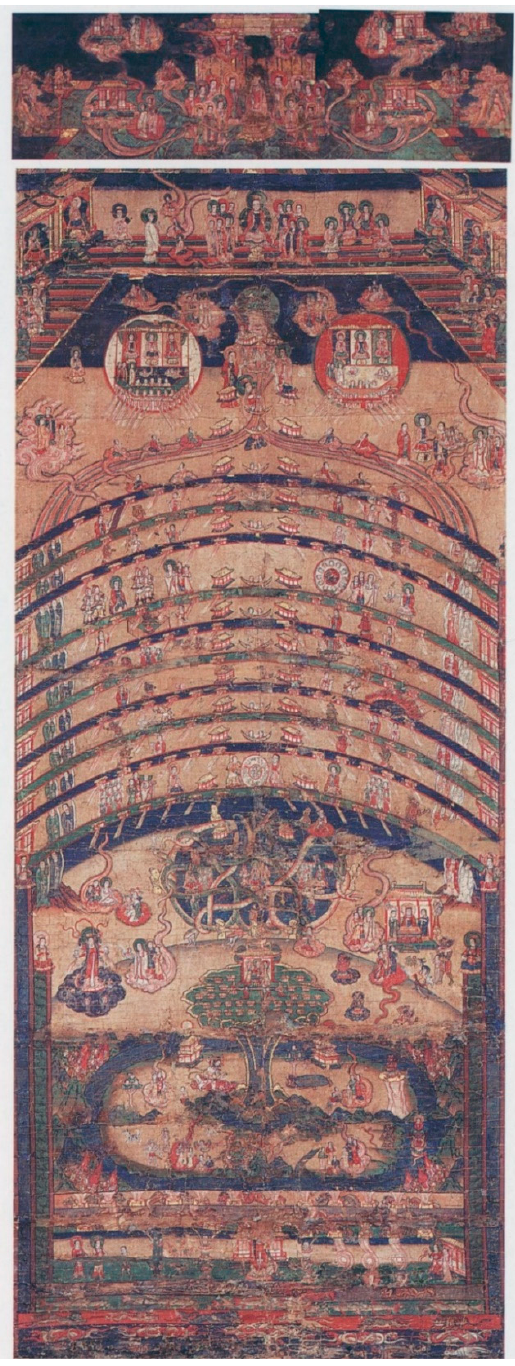
Figure 2. The Diagram of Universe . (Gulácsi 2016, Figure 5/14 [p. 248]).